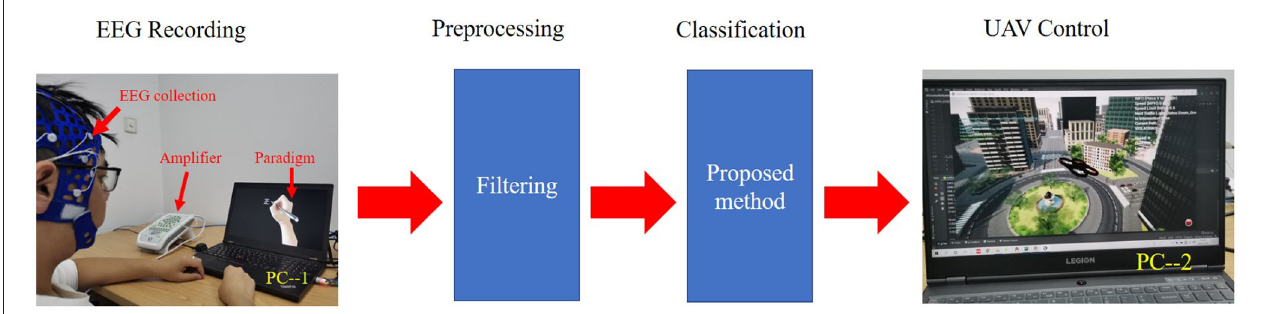
FIGURE 3 | Live setup for real-time electroencephalography (EEG) signal decoding and unmanned aerial vehicle (UAV) control. PC–1 is a computer used to display the paradigm. The subjects only looked at PC–1 during the experiment. PC–2 is a computer used to classify and control the UAV. The classification model was trained in